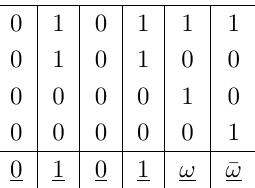
Table 1 . Illustration of the MOG construction of a Golay code word from an even interpretation of the hexacode word 0101 ! (cid:22) ! which is displayed along the bottom of the table. See table 1 for an illustration of this construction. We will refer to